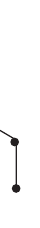
Figure 17: The tree T